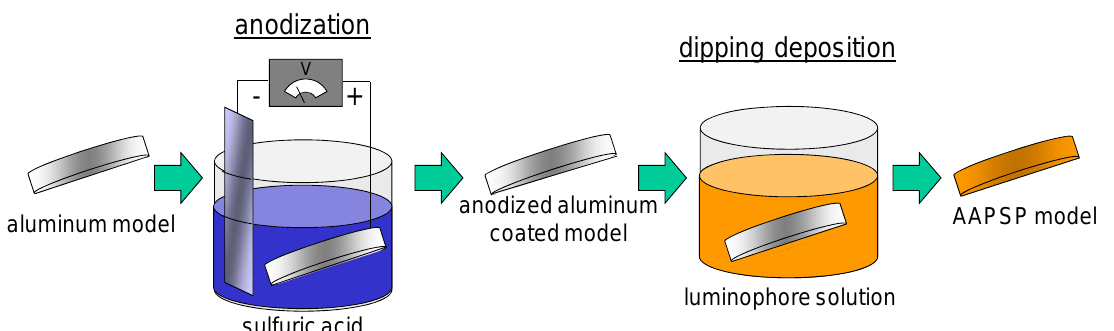
Figure 2. Schematic description of dipping deposition method.